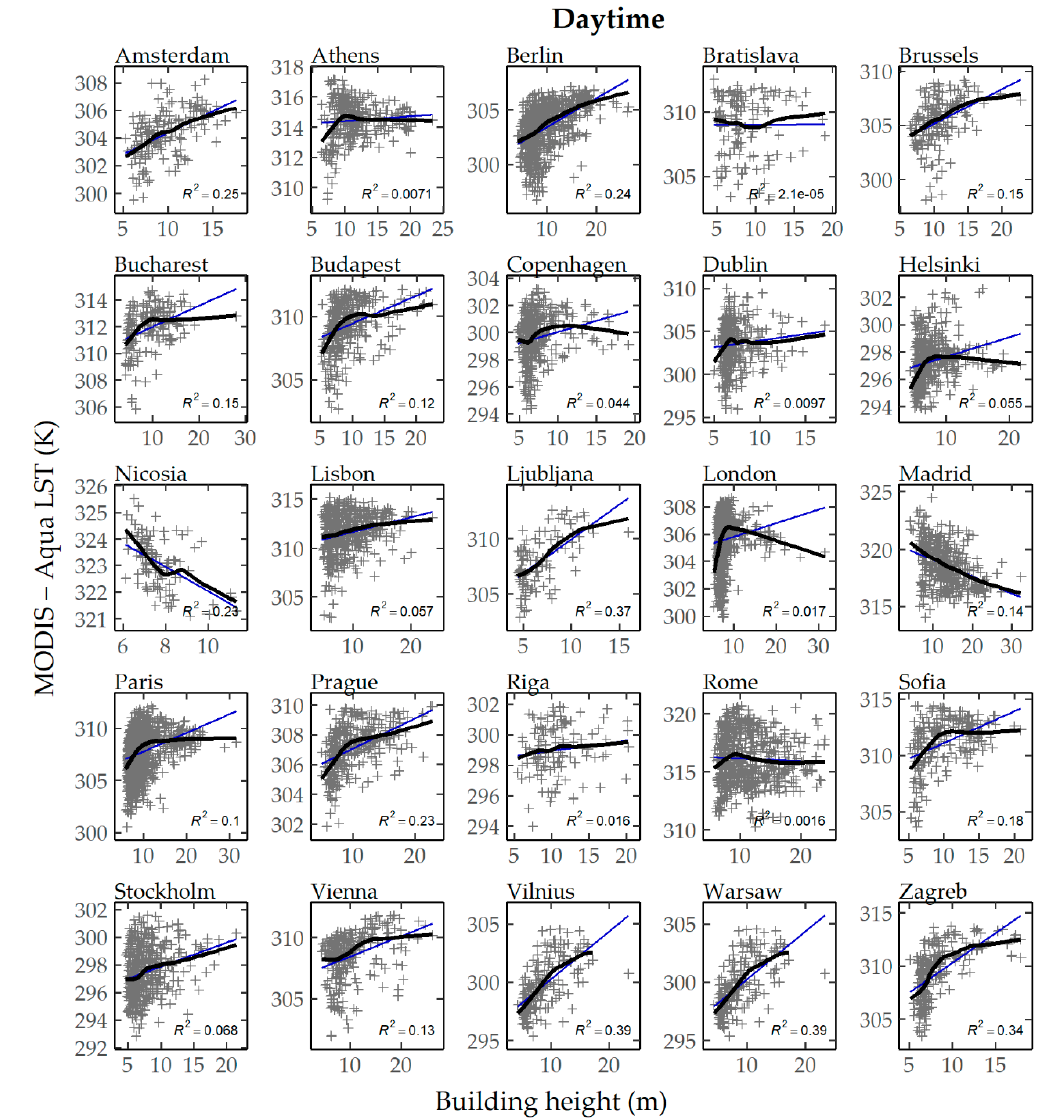
Figure 6. The relationship between LST and H for all cities during daytime. Black curves correspond to the lowess regression lines. Blue lines and R 2 correspond to the linear regression fit.